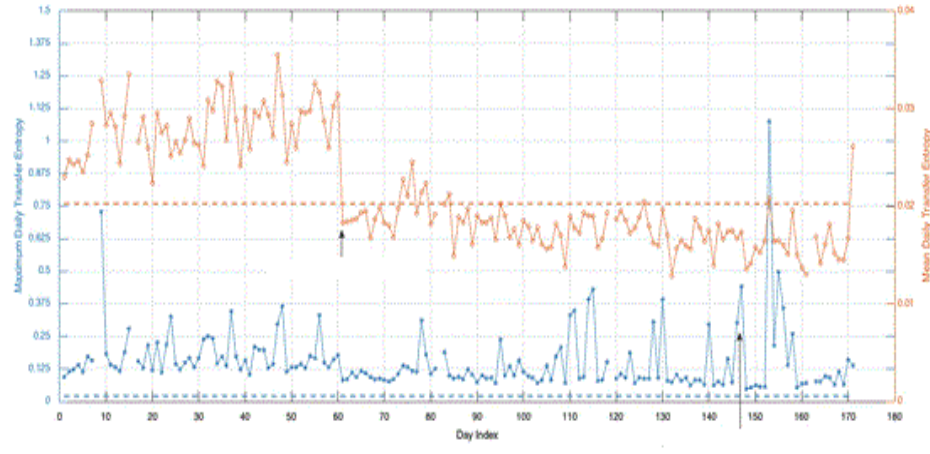
Figure 7. Mean transfer entropy or average transmitted Dow Jones index